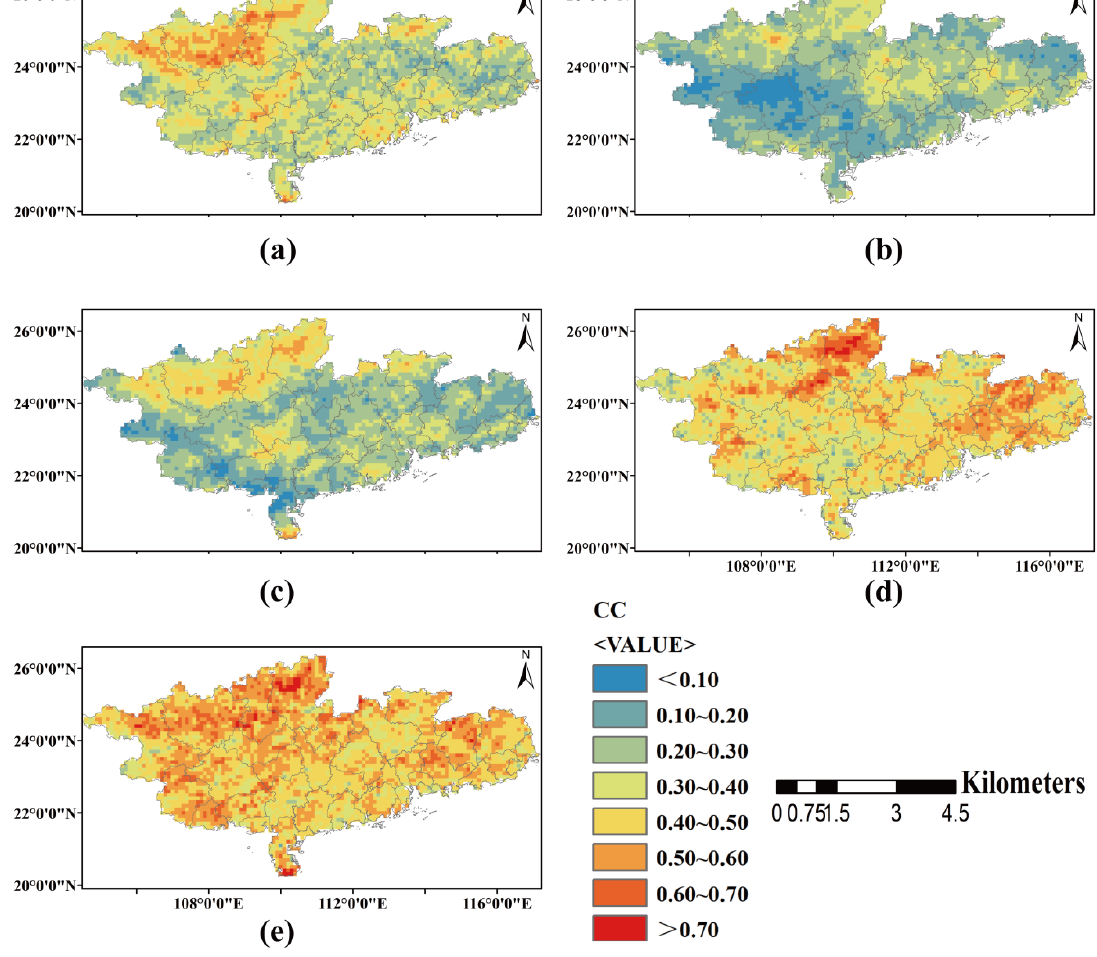
Figure 6. Spatial patterns in terms of correlation coefficient (CC) based on ( a ) PERSIANN-CCS, ( b ) ERA5-Land, ( c ) FY-4A, ( d ) GSMaP, and ( e ) IMERG against CMPA at hourly scale over southern China in summer 2019.